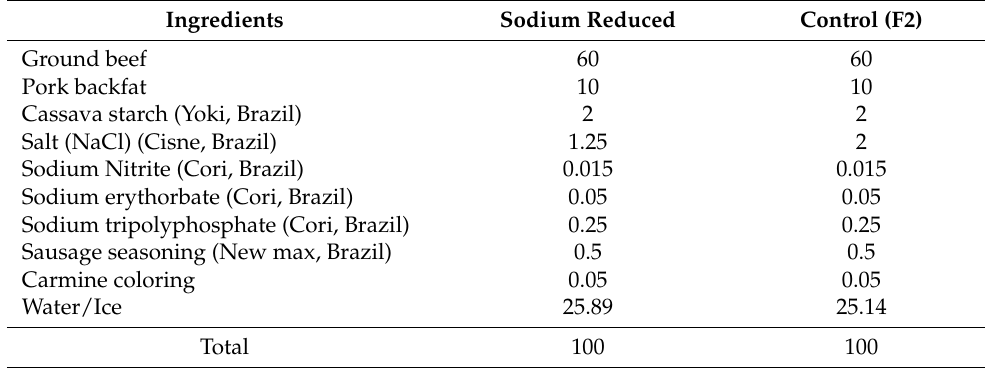
Table 1. Formulations of irradiated and non-irradiated hot